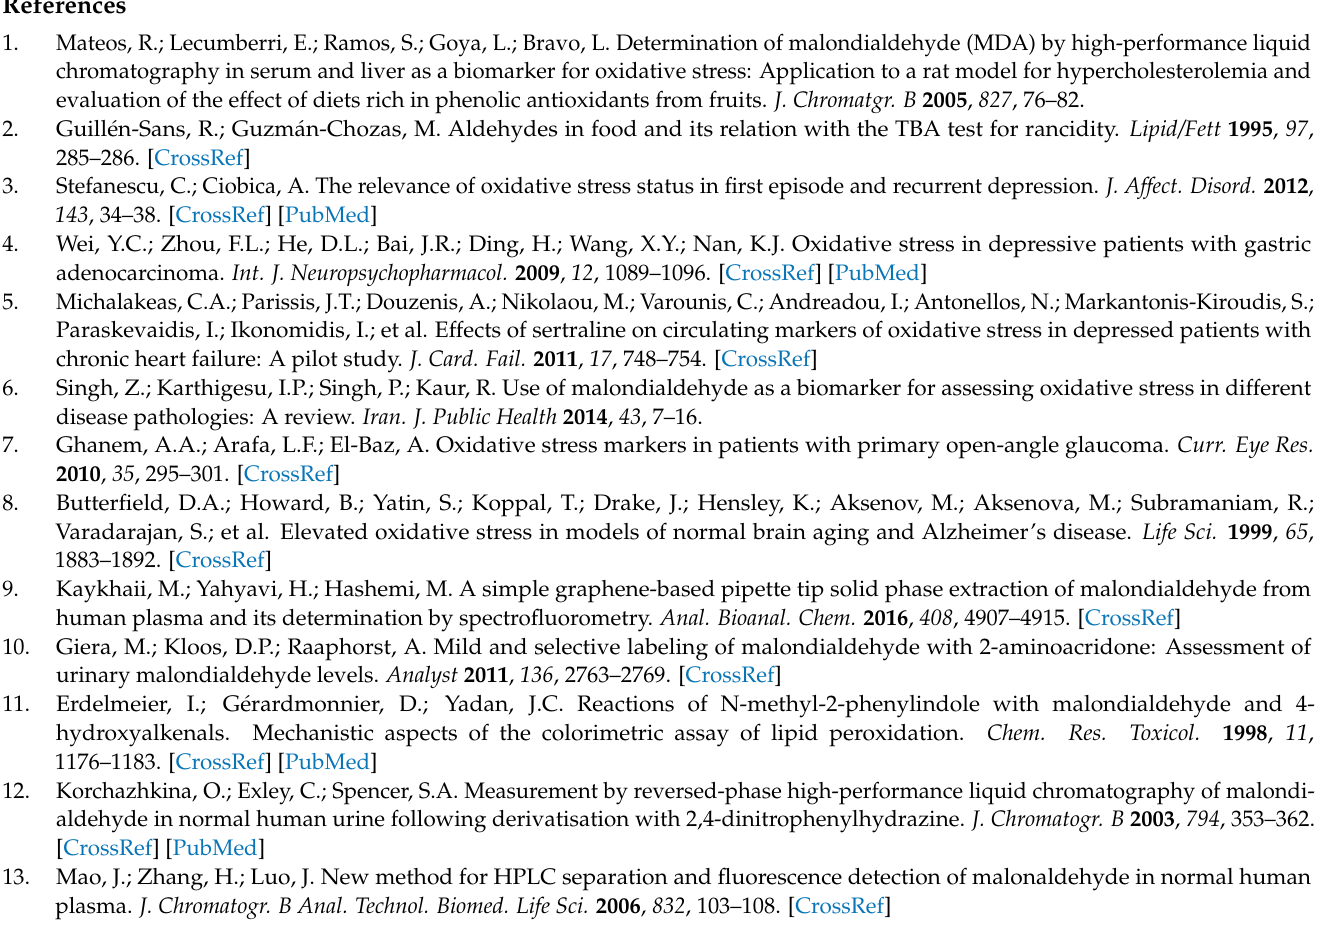
dropping the solution on clean glass sheets for detection. The integral time was 10 s. (b) The Table S1: Correspondence between concentration of phosphoric acid injected to the chip, inside the chip and resulted final pH value; Equation (S1): Definition of SERS enhancement factor